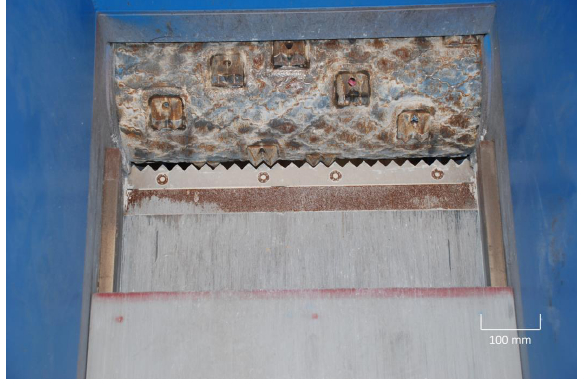
Figure 3. Inside view of the single roll shredder ( top : toothed cylinder, bottom : push-piece). The toothed roll crusher is equipped with two opposite toothed cylinders (Figure 4).